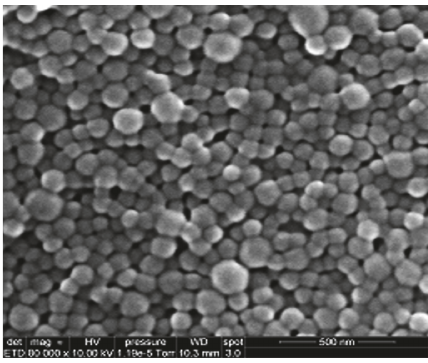
Figure 4: SEM image of PLA nanoparticles prepared by the nanoprecipitation method (scale bar represents 500